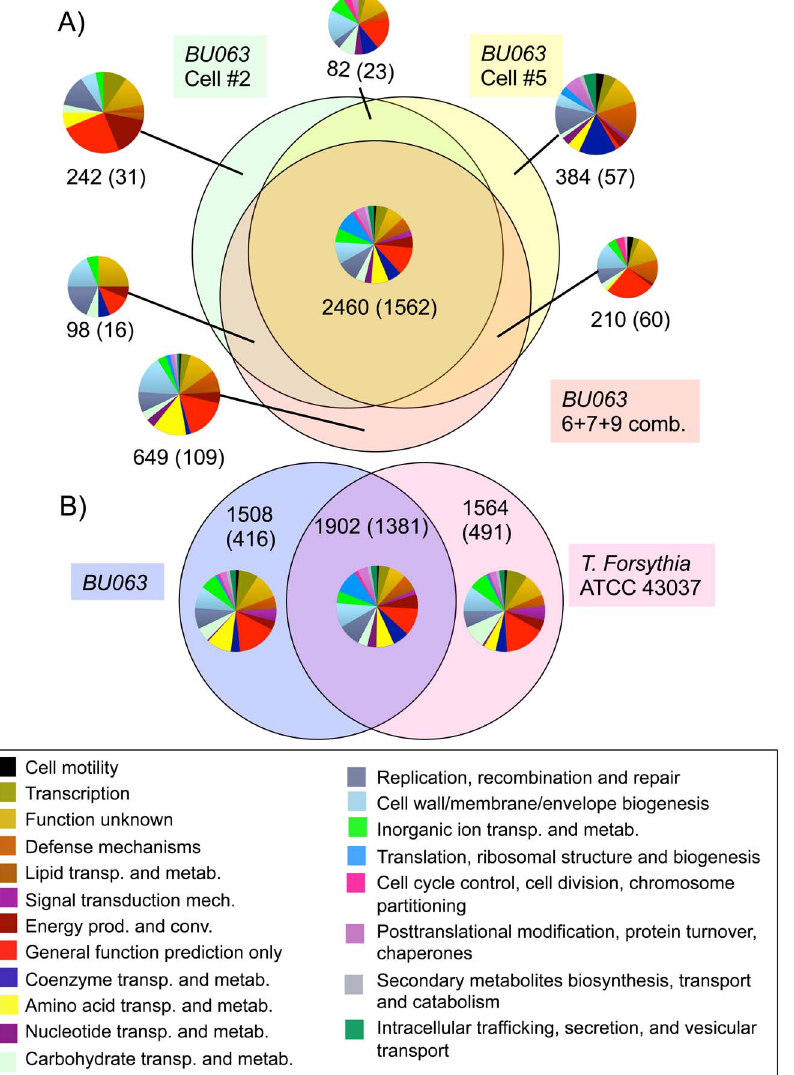
Figure 2. Venn diagrams showing numbers of shared protein-coding genes between various assembled genomes. The first number is the total number of genes in each section, while the number in parentheses is the number of genes that were assigned to COGs. The distribution of COG categories is shown as a pie chart with colors as in the legend A) Venn diagram for the three most complete assemblies of Tannerella BU063 . B) Venn diagram showing average numbers comparing BU063 to Tannerella forsythia